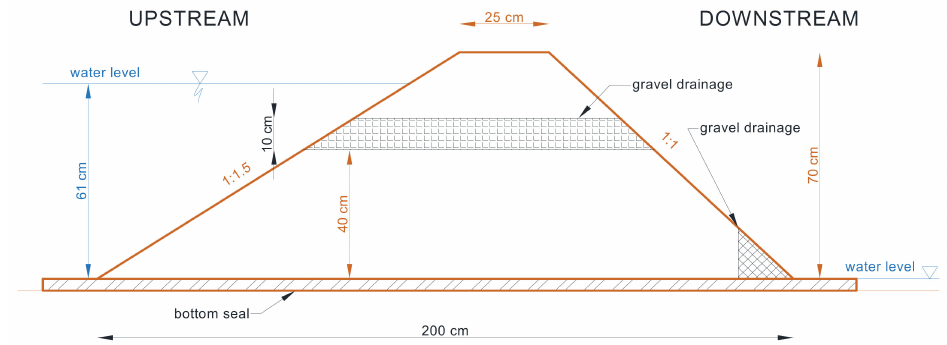
Figure 4. Cross-section of the model embankment with embedded gravel drainage covered with a geotextile.